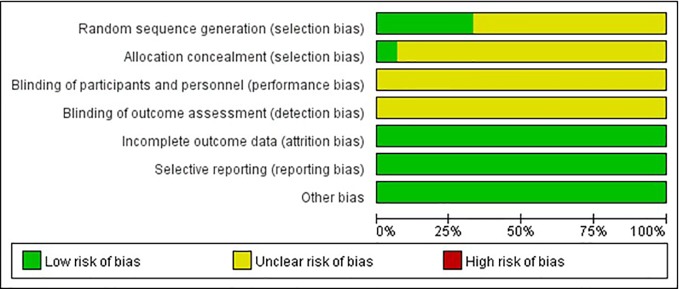
Risk of bias graph.